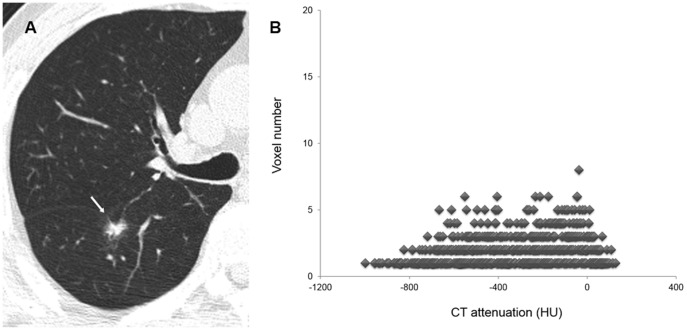
An example of texture analysis of a persistent PSN.(A) Thin-section CT scan shows an 18 mm PSN (arrow) with fissural retraction in the right lower lobe in a 62-year-old male. (B) Texture analysis of the PSN shows high mean attenuation and low negative skewness (−305.5 Hounsfield units and −0.378, respectively). As this PSN was persistent, he underwent lobectomy and was diagnosed as having adenocarcinoma.